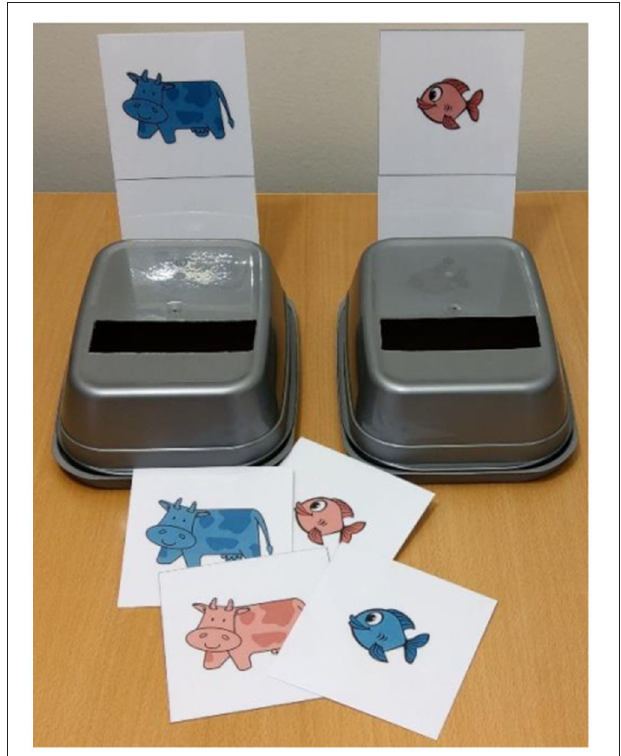
FIGURE 2 | Materials for the Dimensional Change Card Sort